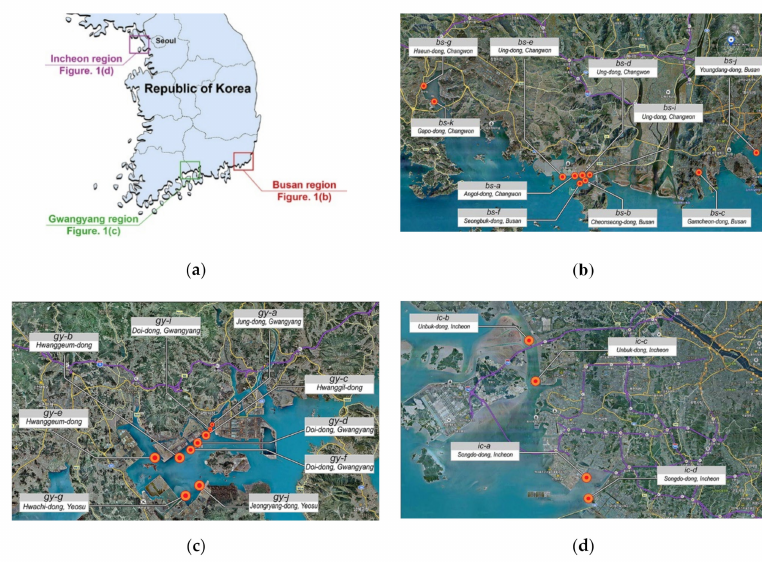
Figure 1. Sampling locations: ( a ) the regions in Korea; ( b ) the Busan region; ( c ) the Gwangyang region; ( d ) the Incheon